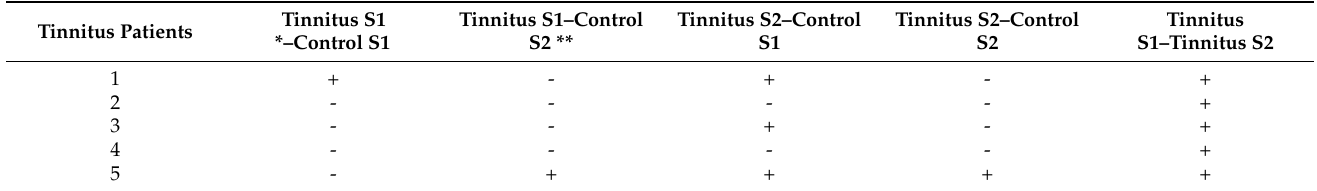
Table 6. p -values as a result of between-subjects design where the Student’s t -test was applied in each tinnitus subject versus the control participants in different sessions undertaken before and after the sound-based treatment.